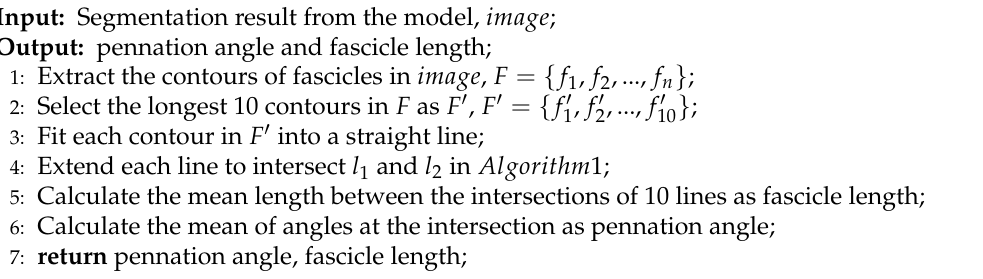
Algorithm 2 Calculating the pennation angle and fascicle length.